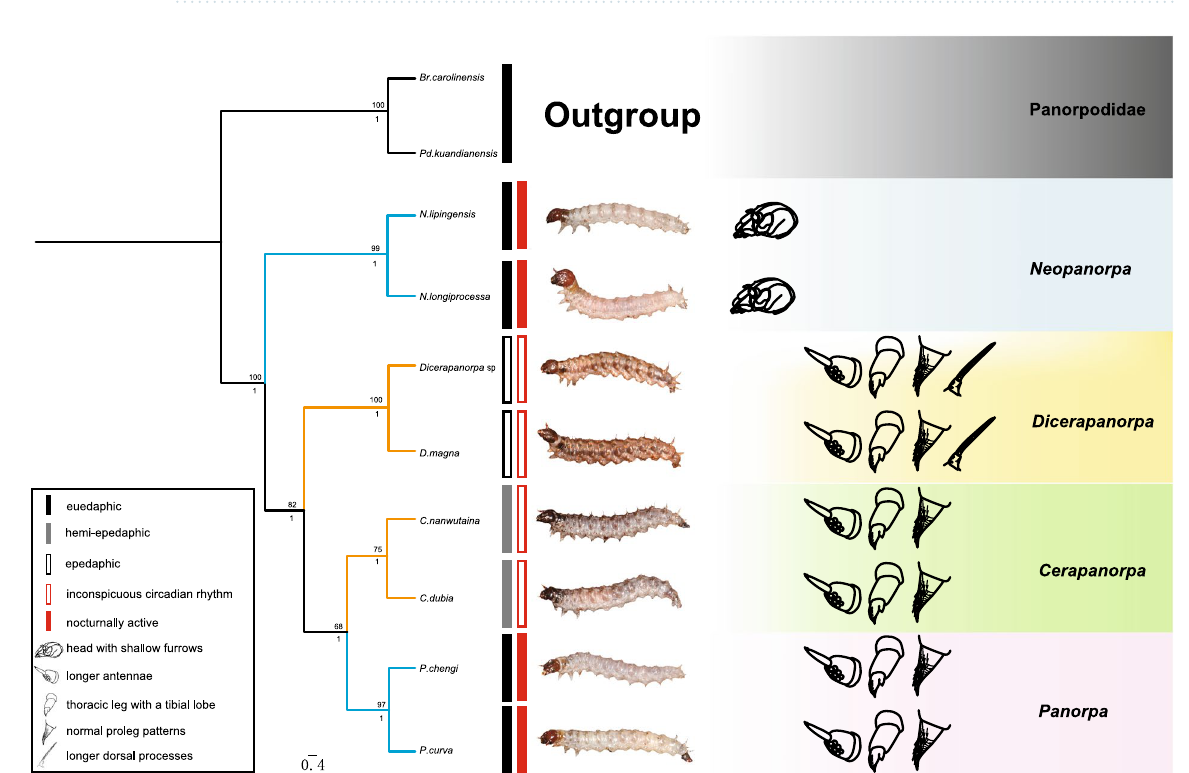
Figure 6. Maximum likelihood chronogram of the eight panorpid species inferred from the concatenated COI , COII and 28S . Node numbers above nodes show bootstrap values, numbers below node show posterior probability. The vertical bars in the middle depict the larval habits of species. The right markings show the morphological features of panorpid